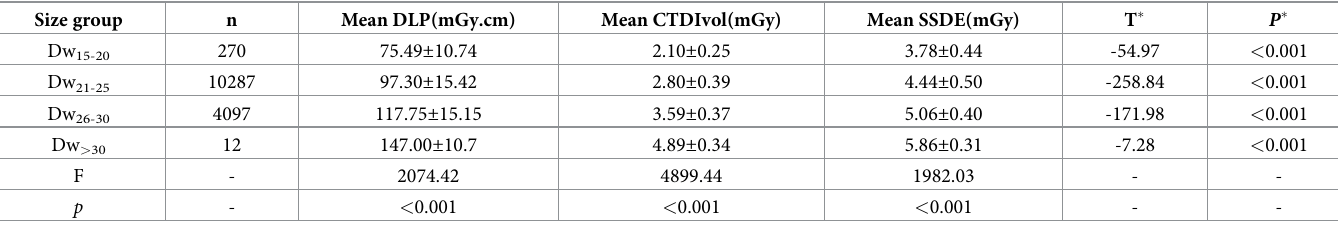
Table 3. CTDIvol, DLP, and SSDE analysis among subgroups, and comparison CTDIvol and SSDE between groups.